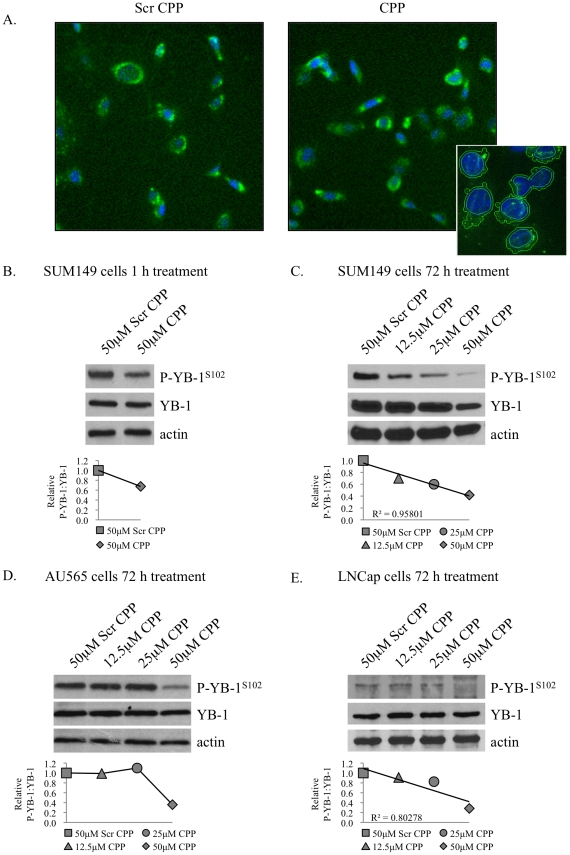
The CPP decreased YB-1 phosphorylation.
A. To demonstrate the CPP entered cells, SUM149 cells were treated with either biotin-labeled scrambled CPP (1.25 µM, left panel) or CPP (1.25 µM, right panel) for 1 h and then visualized by detecting the biotin tag (green color). The nucleus was stained with Hoechst and is shown in blue. B. The CPP decreased P-YB-1S102 by 32% in as little as 1 h in SUM149 cells. C–E. Further, the CPP decreased phosphorylation of YB-1S102 following 72 h treatment in SUM149, AU565, and LNCap cells, respectively. Blots were quantified using ImageJ software and relative P-YB-1:YB-1 is shown below the western blots.